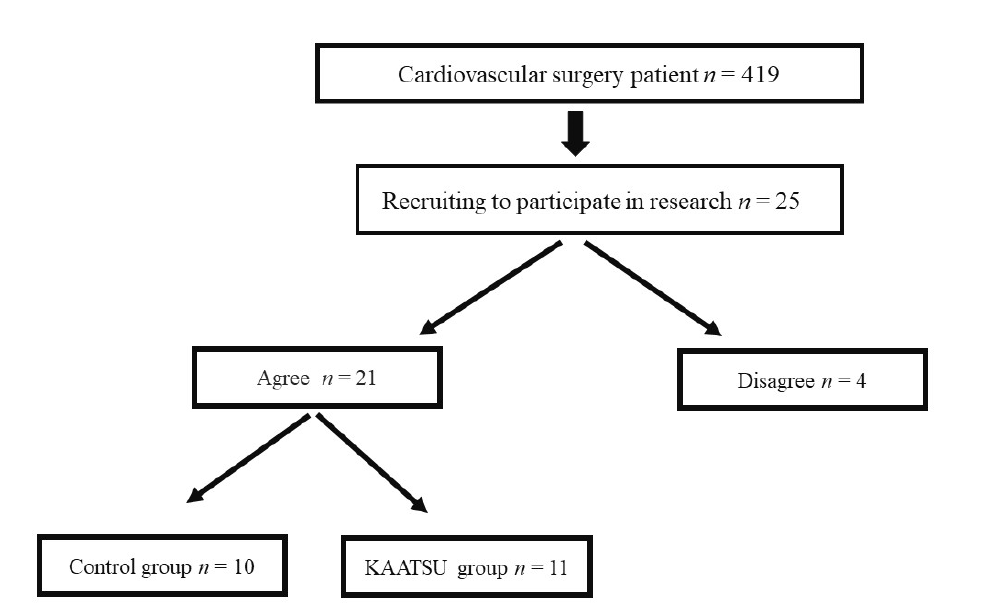
Figure 1. Patient Figure 1. Patient selection. Table 1. Inclusion and exclusion criteria.